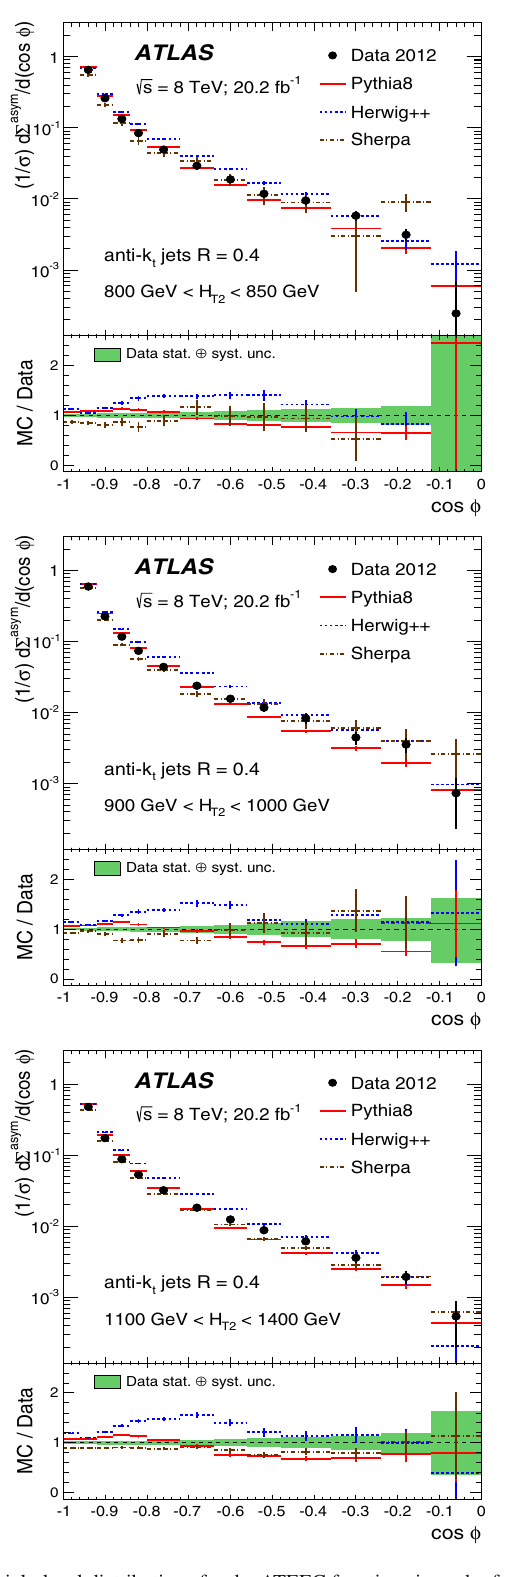
ing statistical and other experimental sources is also indicated using an error bar for the distributions and a green-shaded band for the